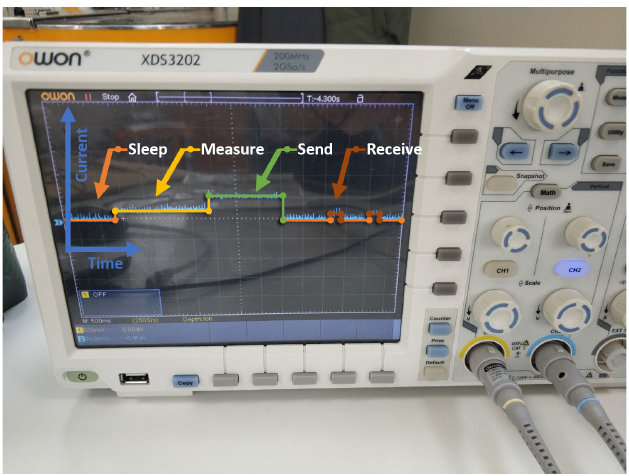
Fig. 6. One cycle in oscilloscope screen.